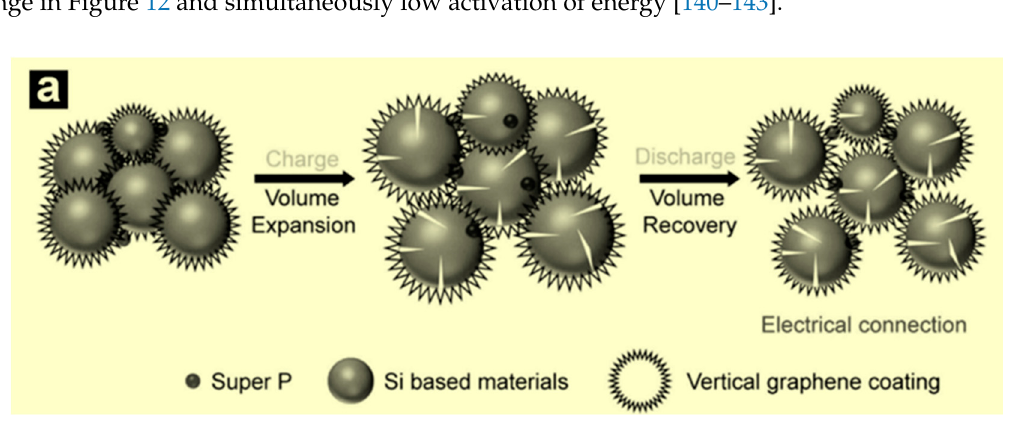
Figure 12. Schematic illustration of the d-SiO/vG during charge/discharge.